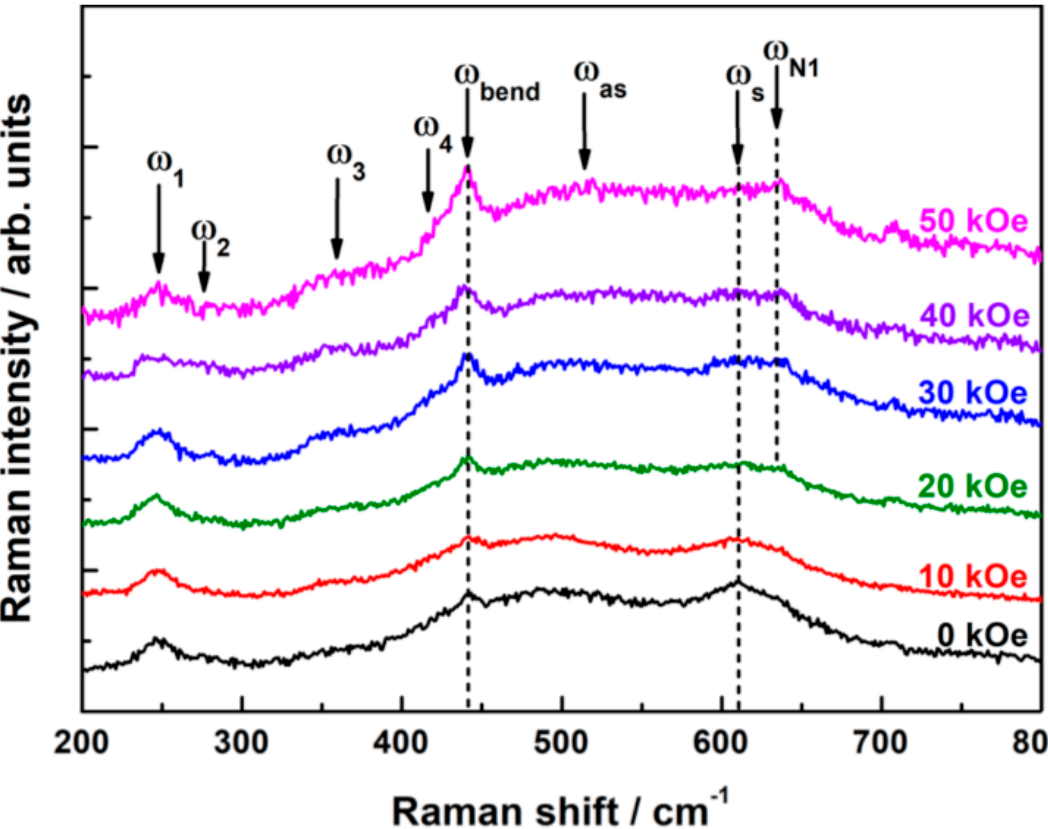
/ MgO film measured close to T